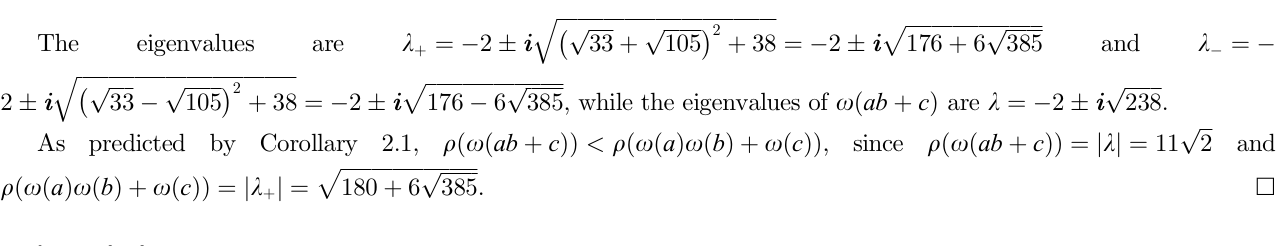
ffiffiffiffiffiffiffiffiffiffiffiffiffiffiffiffiffiffiffiffiffiffiffiffiffiffiffi